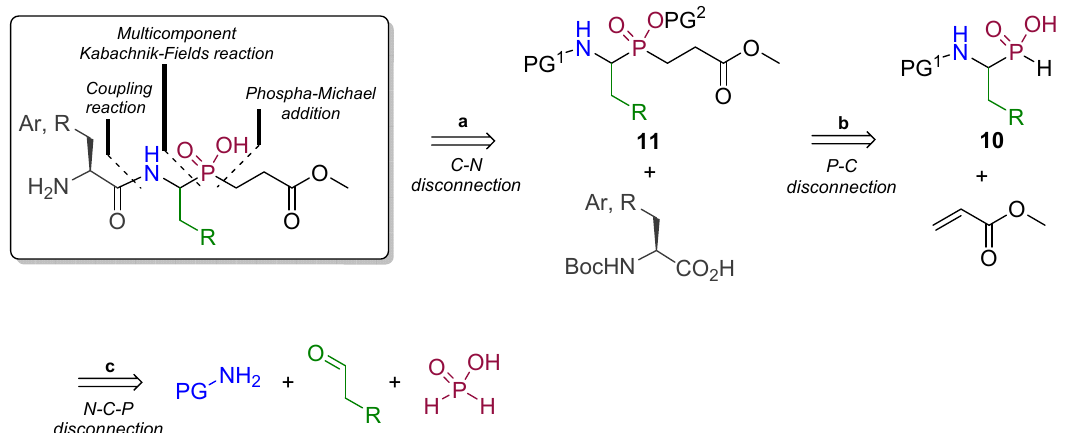
Figure 2. Putative phosphinic pseudotripeptides derived from leucine and homophenylalanine containing modified P2 substituents as inhibitors of leucylaminopeptidase.